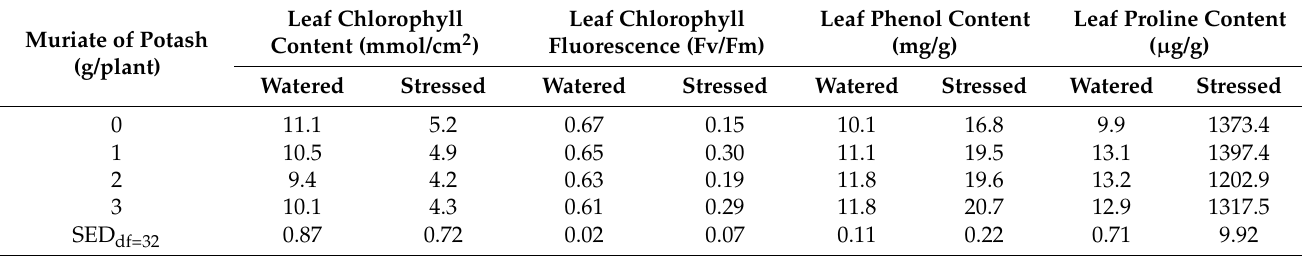
Table 5. Leaf chlorophyll content and fluorescence, and leaf contents of total phenol and proline of cocoa seedlings as influenced by watering regime and potassium application in experiment 1.